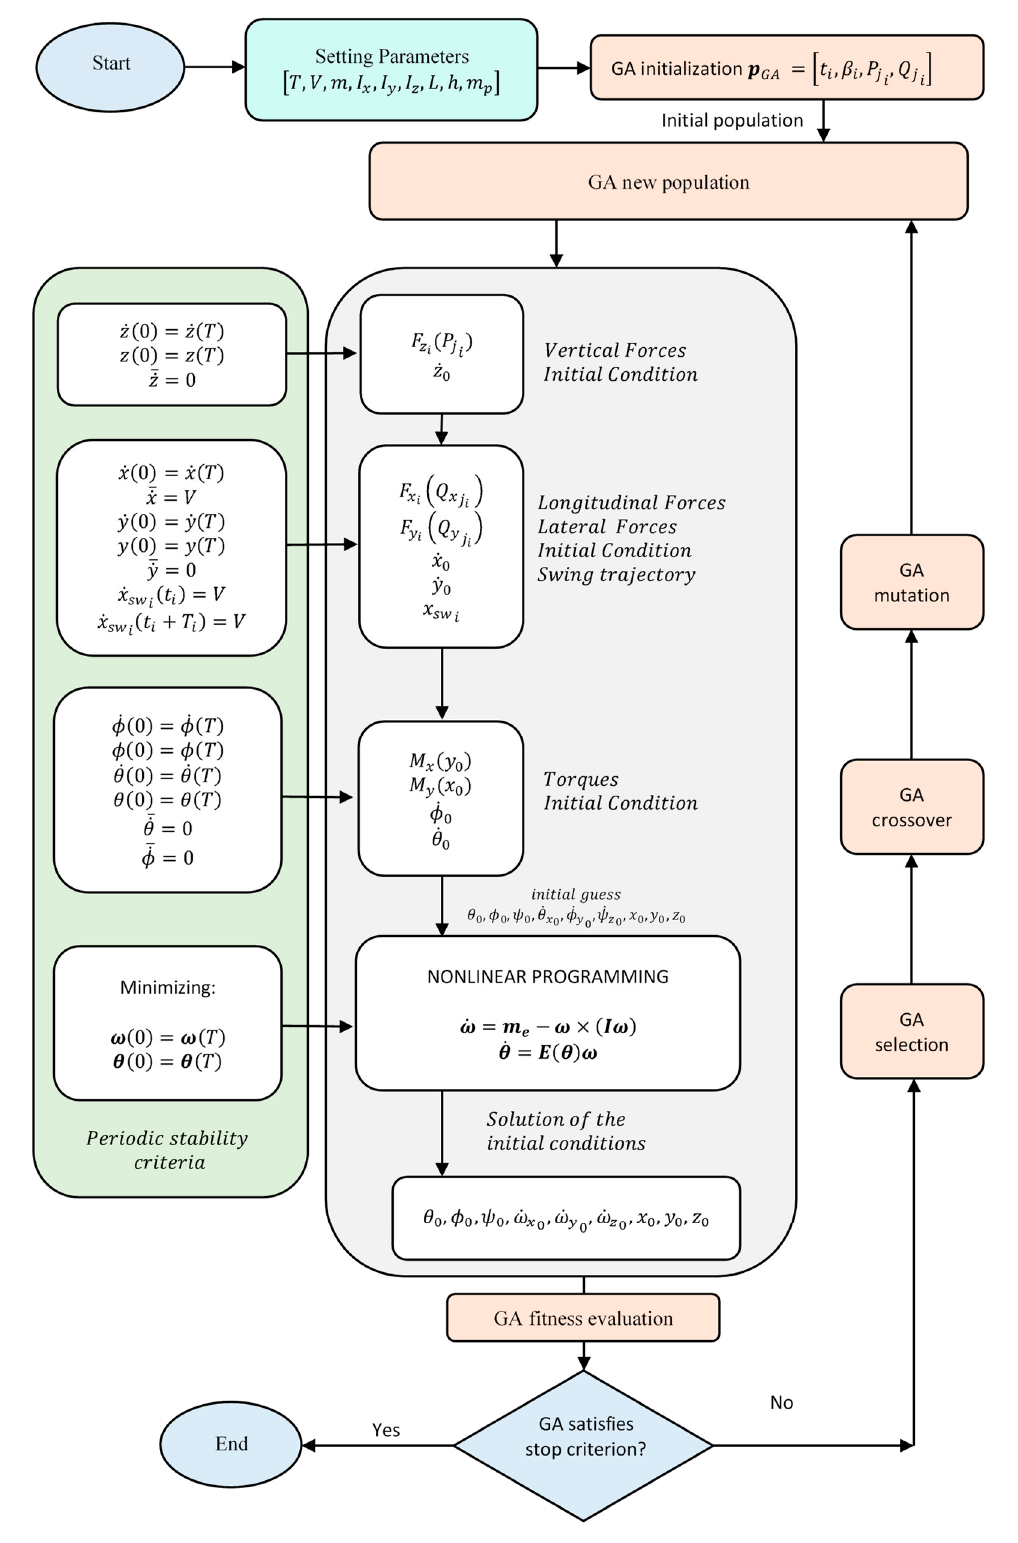
Figure 7. Optimization diagram of the genetic algorithm (GA) algorithm. Eventually, we introduce the multi-objective function to be minimized for the most efficient gait. The GA’s fitness function is defined through the total specific energy 𝐸 (cid:3031) ,